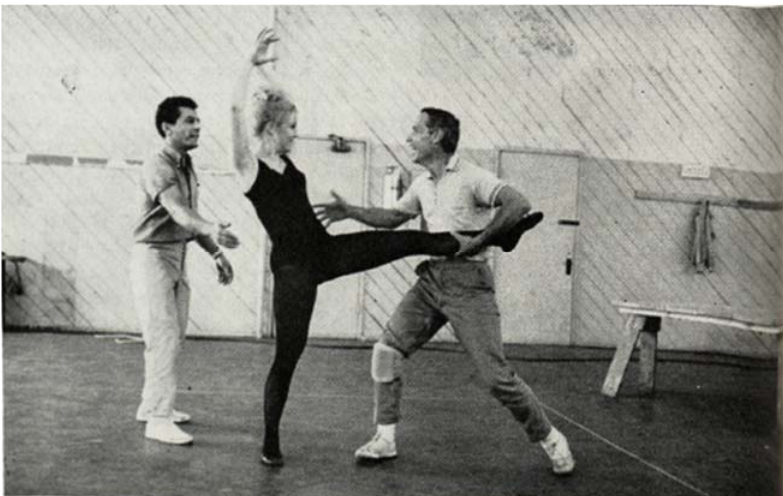
Figure 5. Alex Ruiz, Yvette Mimieux, and Alex Romero in rehearsal for The Wonderful World of the Brother Grimm (1962). Photographs by Seymour Linden for Dance Magazine (January 1962).